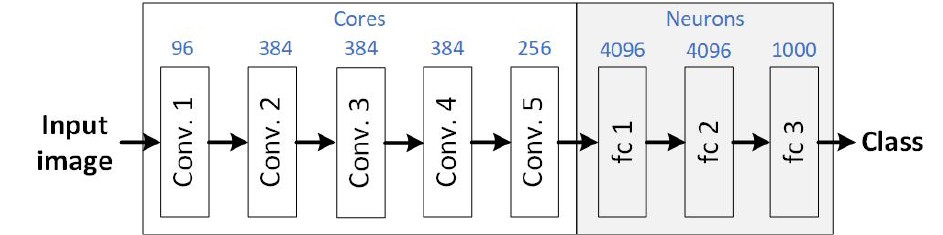
Figure 6. General scheme of the AlexNet